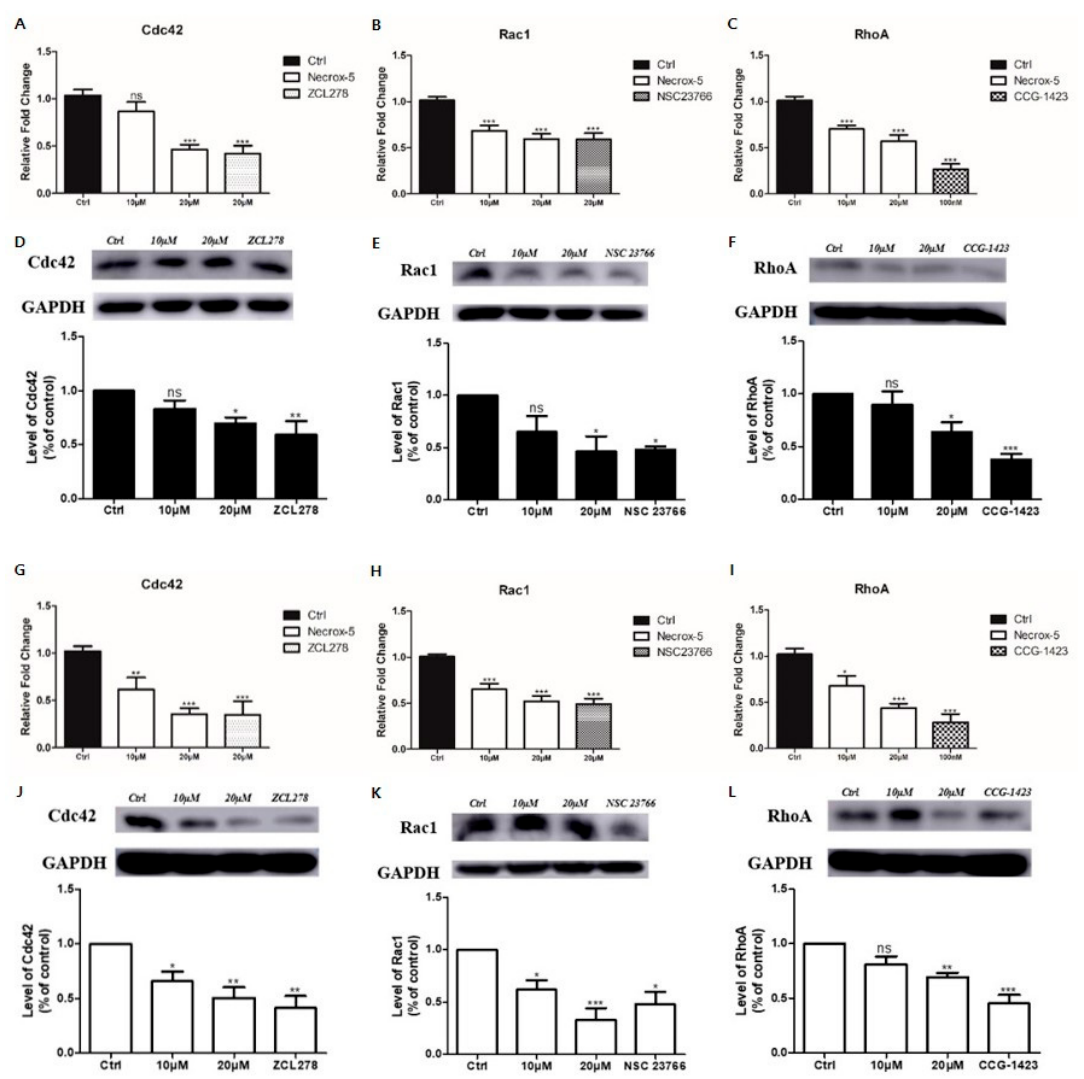
Figure 3. The effect of NecroX-5 treatment on the expression of Rho family GTPases (Cdc42, Rac1, and RhoA). A375P ( A – F ) and A375SM ( G – L ) were treated with 10 µ M or 20 µ M NecroX-5 for 24 h. The mRNA expression levels of Cdc42, Rac1, and RhoA were measured by qRT-PCR ( A – C , G – I ). The protein levels of Cdc42, Rac1, and RhoA were measured using western blot analysis ( D – F , J – L ). GAPDH was used as an internal control for mRNA and protein normalization (ZCL278 (10 µ M), Cdc42 GTPase inhibitor; NCS23766 (10 µ M), Rac GTPase inhibitor; CCG-1423 (100 nM), RhoA GTPase inhibitor). Results are expressed as the mean ± SEM from three independent experiments. * p < 0.05, ** p < 0.01, *** p <